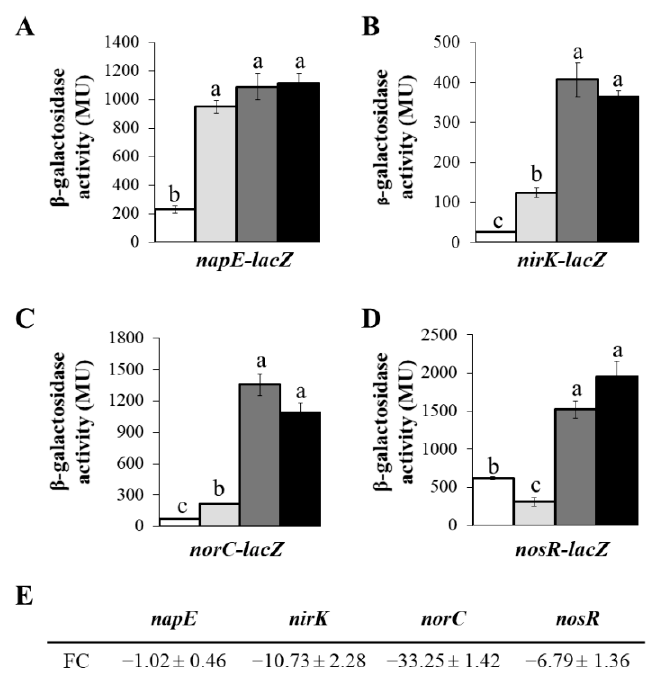
Figure 2. Transcriptional expression of denitrification genes monitored as β -galactosidase activity from napE-lacZ ( A ), nirK-lacZ ( B ), norC-lacZ ( C ) and nosR-lacZ ( D ) fusions chromosomally integrated in B. diazoefficiens 110 spc 4 grown aerobically in Cu-S (white bars) and microaerobically in Cu-L (light grey bars), Cu-S (dark grey bars) and Cu-H (black bars) BVMN media for 3 days. A post-hoc Tukey HSD test at p ≤ 0.05 was applied in ( A )–( D ); same lower-case letters in each figure indicate that values are not statistically different. ( E ) Expression changes of napE , nirK , norC and nosR genes in B. diazoefficiens 110 spc 4 grown microaerobically in Cu-L compared with Cu-S measured by qRT-PCR. Data expressed as Miller Units (MU) and Fold Change (FC) are means with standard deviation from at least three independent cultures assayed in triplicate.